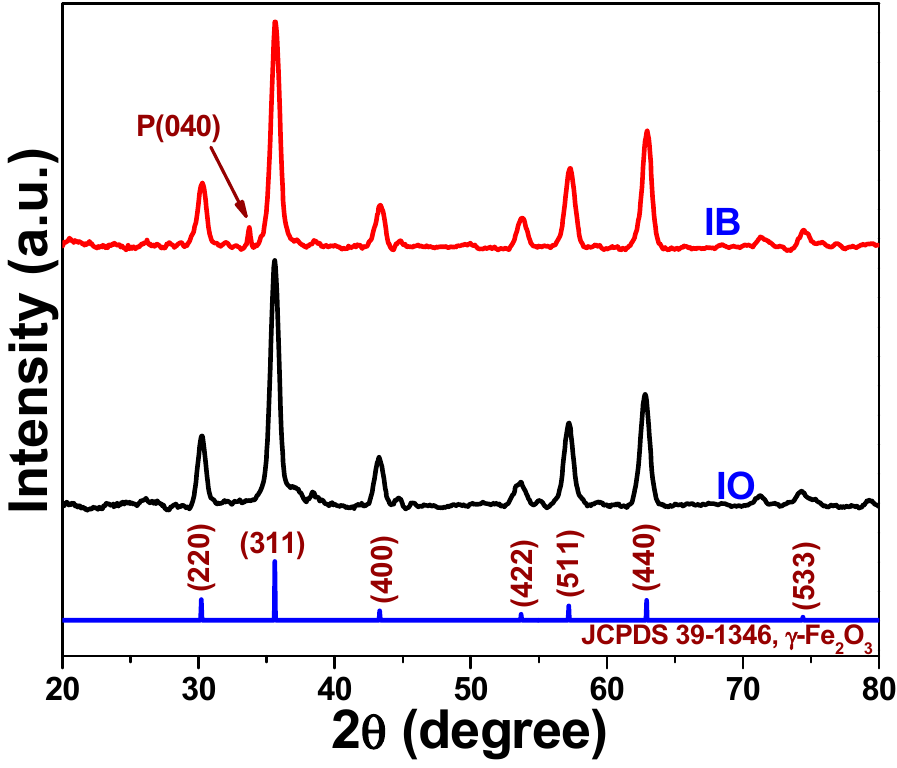
Figure 1. X-ray diffraction patterns of the γ -Fe 2 O 3 (IO) and black phosphorus-based γ -Fe 2 O 3 (IB) samples.